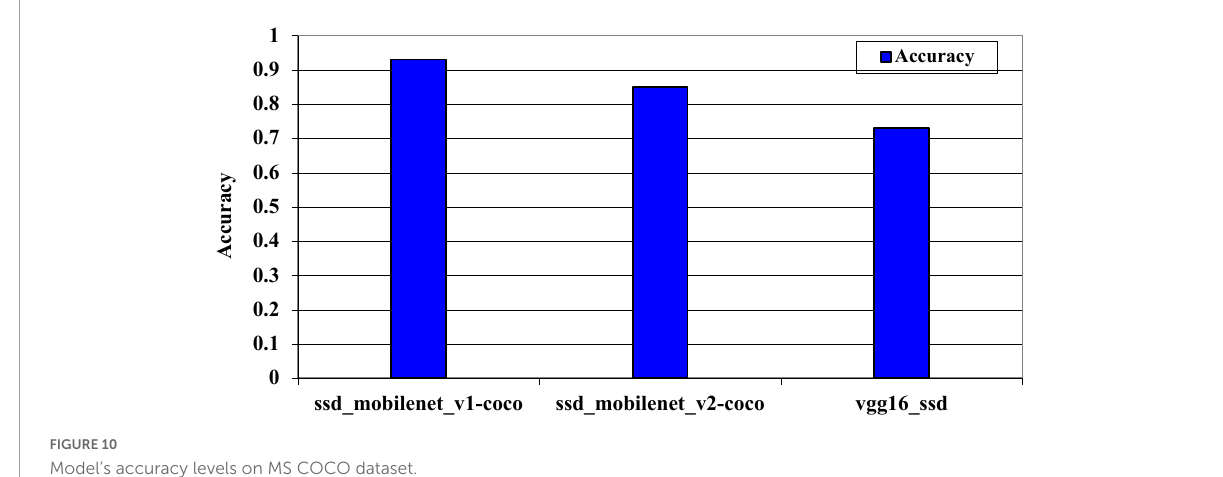
FIGURE10 Model’s accuracy levels on MS COCO dataset.